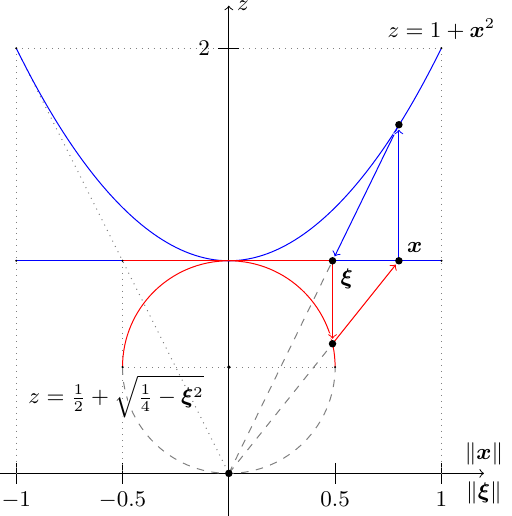
Figure 2. Interpretation of the distortion and undistortion functions for α = 1 . Sensor plane and scene plane are at z = 1 . Undistortion: (1) parallel project x from the sensor plane along z onto the paraboloid z = 1 + x 2 and (2) central project it back through the origin to ξ on the scene plane. Distortion: (1) parallel project ξ from the scene plane along − z onto the upper (cid:113) 1 + − ξ 2 and (2) central project it back half sphere z = 1 2 4 through the origin to x on the sensor plane.